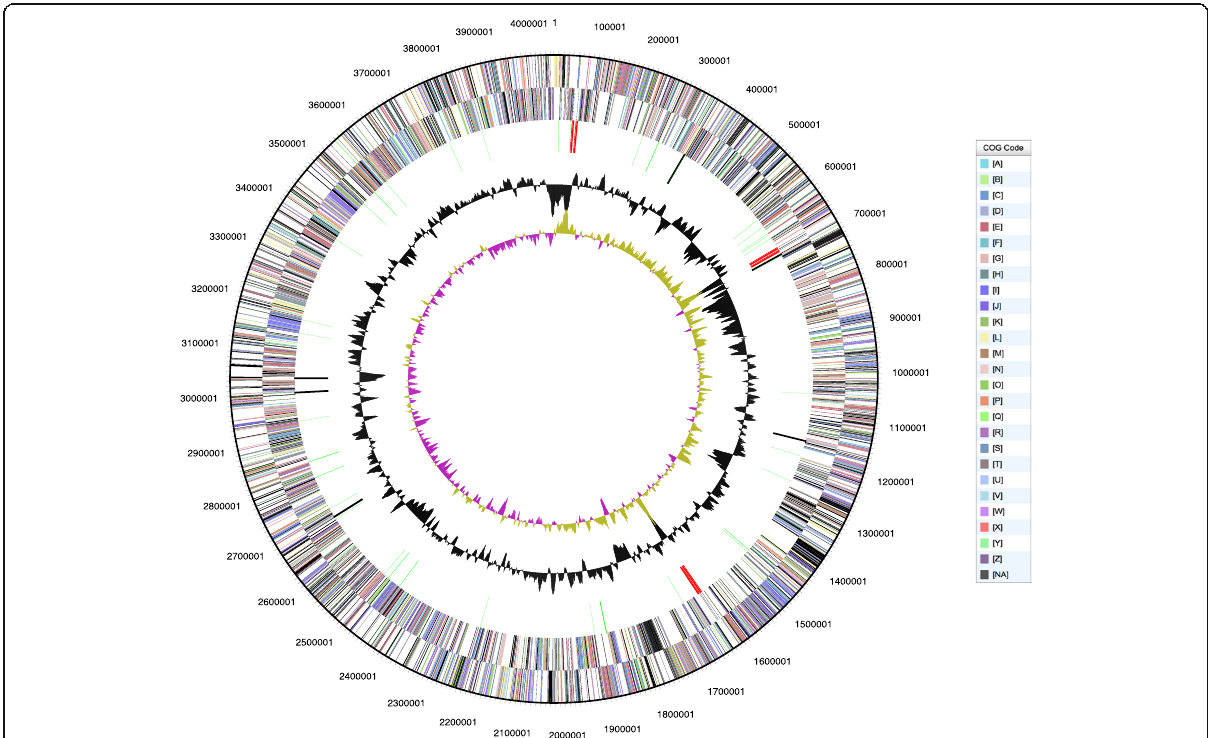
Fig. 3 The genome graphical map of strain R3.8. From the outside to the center: genes on forward stand and genes on reverse strand ( color by COG categories see legend), RNA genes (tRNAs green , rRNAs red , other RNAs black ), GC content, GC